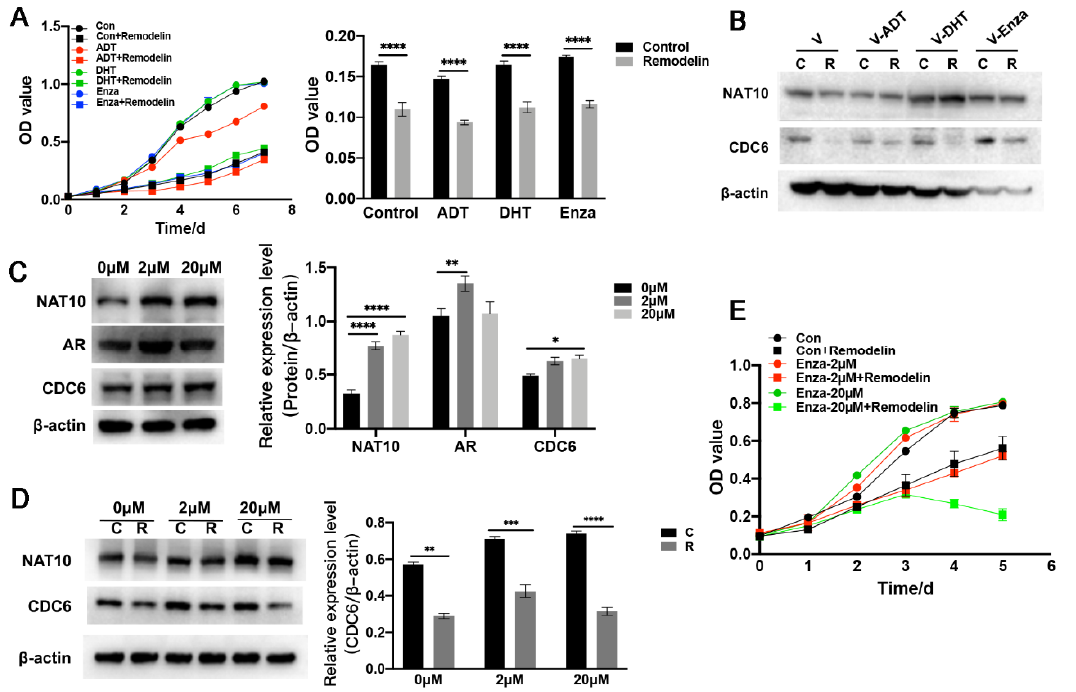
Figure 5. Inhibition of NAT10 suppresses castration-resistant prostate cancer cells in vitro. ( A ) Right panel: VCaP cells were treated with DMSO or Remodelin (20 µ M), combined with cells pretreated with DHT, enzalutamide, and ADT, cell proliferation was evaluated every day, and a growth curve was created after 7 days. Left panel: VCaP cells were treated with DMSO or Remodelin (20 µ M), combined with cells pretreated with DHT, enzalutamide, and ADT for 7 d, cell proliferation was assessed and analyzed by MTS assay. T -test; ****, p < 0.0001. ( B ) VCaP cells were treated with DMSO or Remodelin (20 µ M), combined with cells pretreated with DHT, enzalutamide, and ADT for 24 h. Levels of NAT10 and CDC6 were measured by Western blotting. ( C ) VCaP cells were pretreated with enzalutamide for at least 4 weeks to generate enzalutamide-tolerant (2 µ M) and enzalutamide-resistant (20 µ M) cells. Levels of NAT10, AR, and CDC6 were measured by Western blotting (left panel), and statistical analysis was performed (right panel). One-way ANOVA with Tukey post-hoc test; *, p < 0.05; **, p < 0.01; ****, p < 0.0001. ( D ) Enzalutamide-tolerant (2 µ M) and enzalutamide-resistant (20 µ M) cells were treated with Remodelin or DMSO. Expression levels of NAT10 and CDC6 were determined by Western blotting and statistical analysis was performed (right panel). T -test; **, p < 0.01; ***, p < 0.001; ****, p < 0.0001. ( E ) Cell proliferation of enzalutamide-tolerant (2 µ M) and enzalutamide-resistant (20 µ M) cells was evaluated every day, and a growth curve was created after 5 days. Representative images in each group are shown, and the data were quantified from triplicate experiments, and are presented as the mean ±